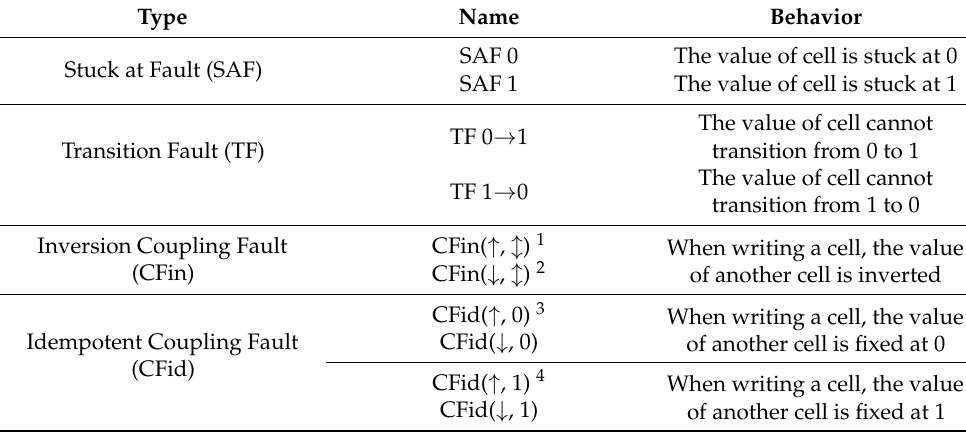
Table 1. Ten types of memory